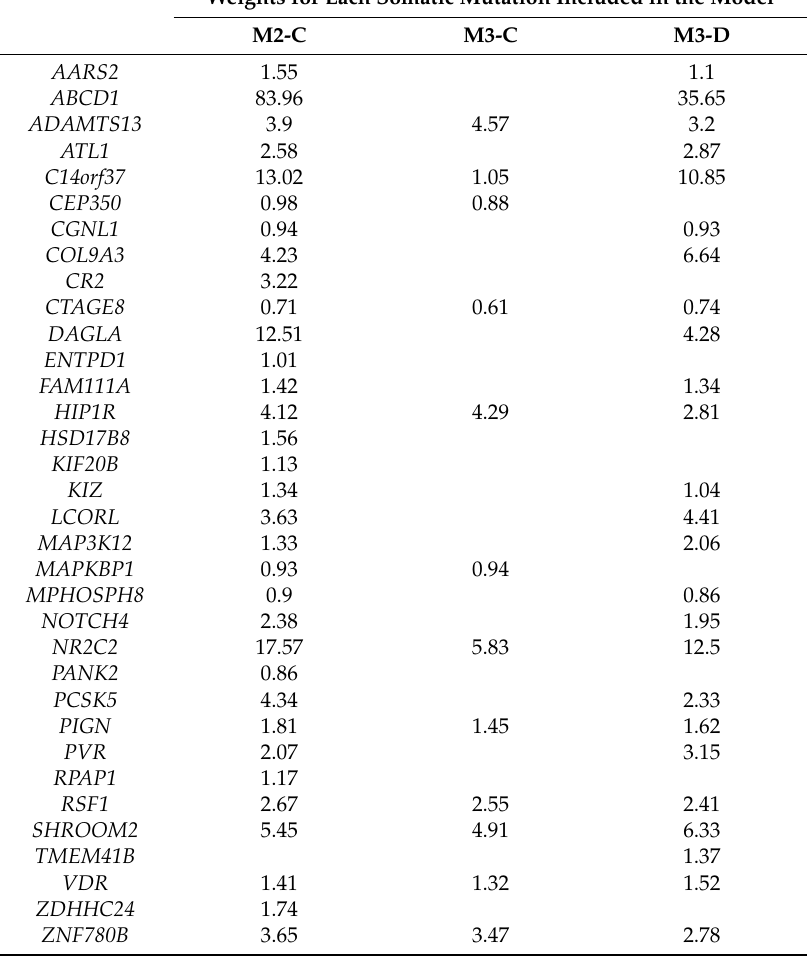
Table A2. Details of individual weights for somatic mutations. For individual scores, multiply the number of mutations per gene and person by the weight in the table. Each model has different